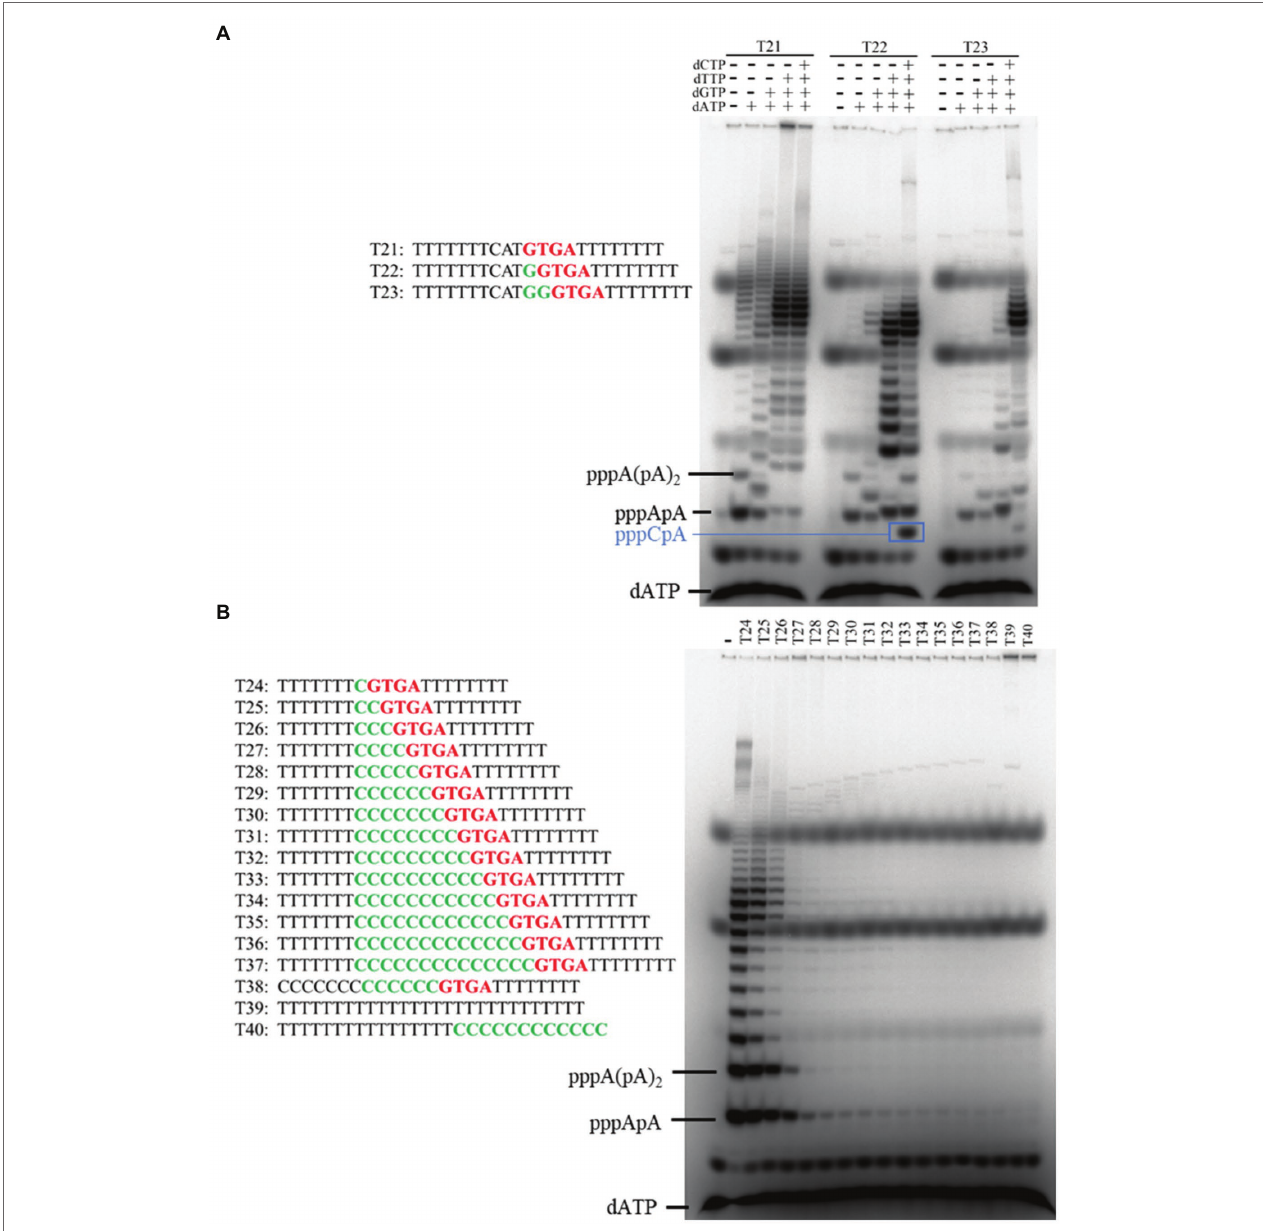
FIGURE 6 | Identification of the initiation site of primer synthesis on the template containing primase recognition site 5 ' -GTGA-3 ' . (A) Primers were synthesized on different templates (T21–T23) in the presence of [ α - 32 P] dATP and indicated dNTPs. (B) Primers were synthesized on different templates (T24–T40) in the presence of dATP and [ α - 32 P] dATP. The products were separated on a 3 M urea-25% PAGE. Data in Figure B are representative of two independent